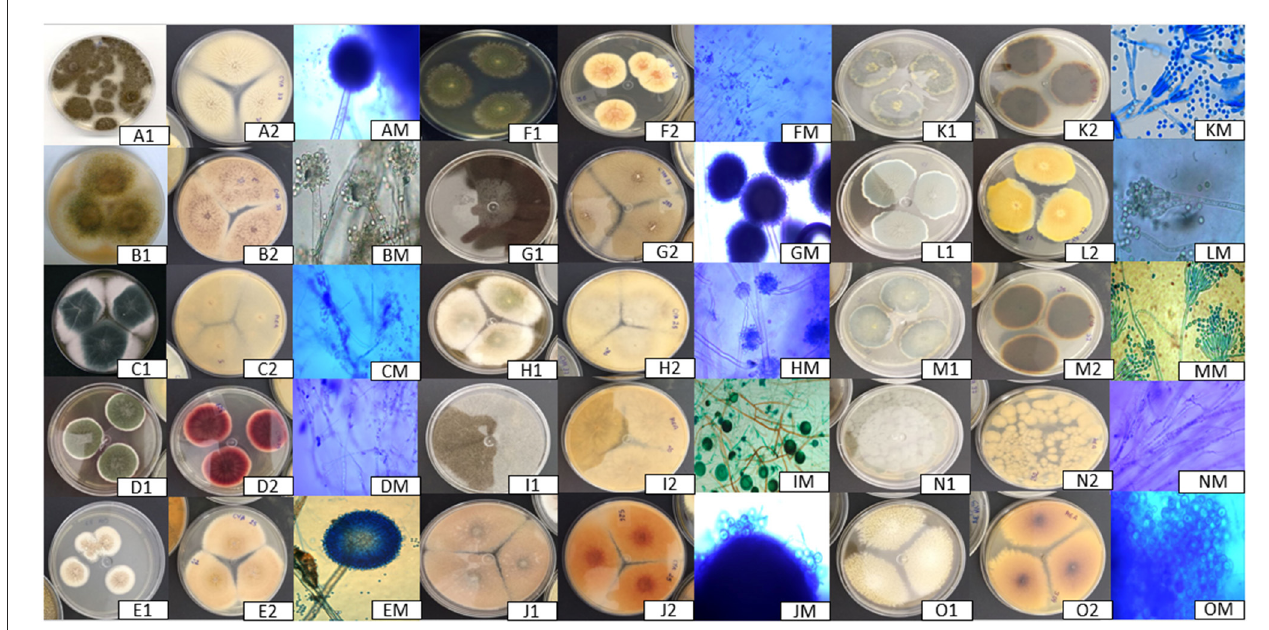
FIGURE2 Photographs of isolated filamentous fungi. 1, Front view of the colony; 2, Back view of the colony; M, Microscopy image. A, Aspergillus tubigiensis ; B, Aspergillus oryzae ; C, Aspergillus fumigatus ; D, Aspergillus sp.; E, Aspergillus ochraceus ; F, Aspergillus caepitosus ; G, Aspergillus niger ; H, Aspergillus parasiticus ; I, Rhizopus ; J, Emericella sp.; K, Penicillium citrinum ; L, Penicillium solitum ; M, Penicillium implicatum ; N, Penicillium sp.; O, Cladosporium